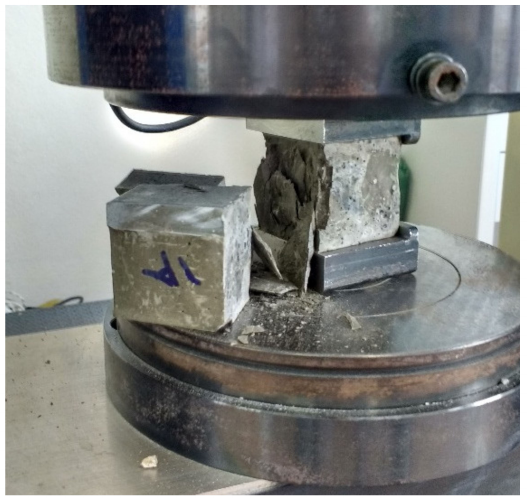
Figure 2. Setup and specimen failure of the compressive strength